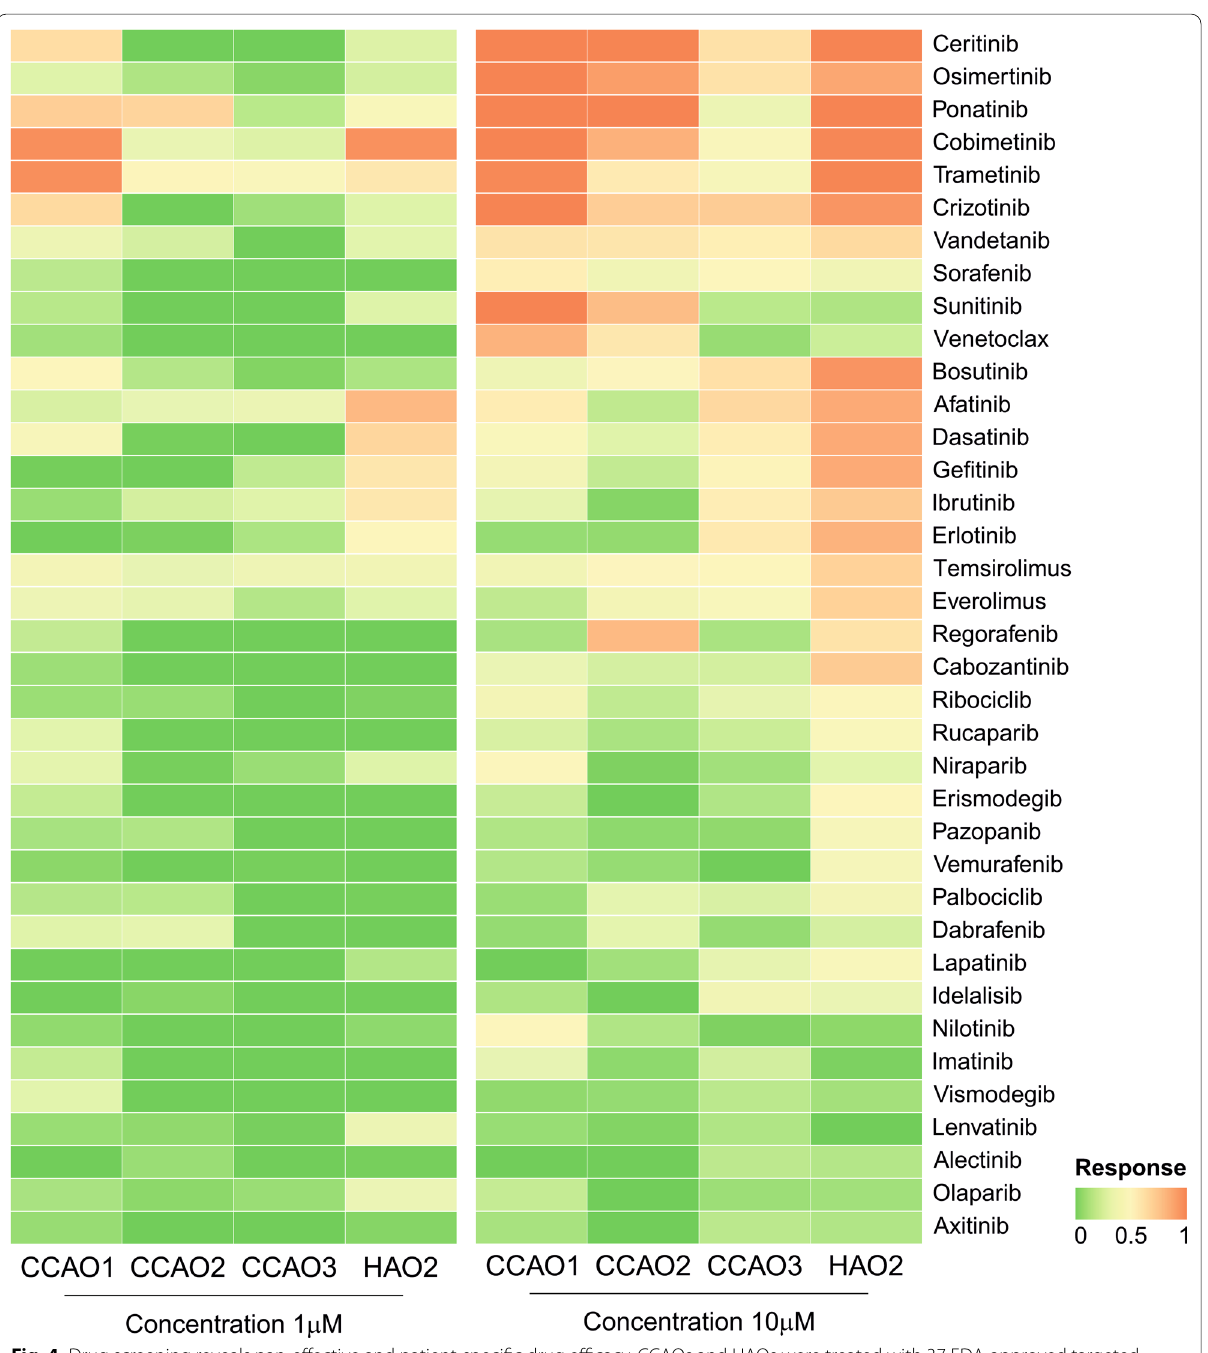
Fig. 4 Drug screening reveals pan-effective and patient-specific drug efficacy. CCAOs and HAOs were treated with 37 FDA-approved targeted therapeutics (Additional file 1: Table S2) at 1 µM and 10 µM concentrations for four days. Drug efficacy is visualized in a heatmap of viability relative to vehicle-treated control organoids. Drug response ranges from 0, indicating that organoids are unaffected by the compound, to 1, indicating complete absence of surviving organoid